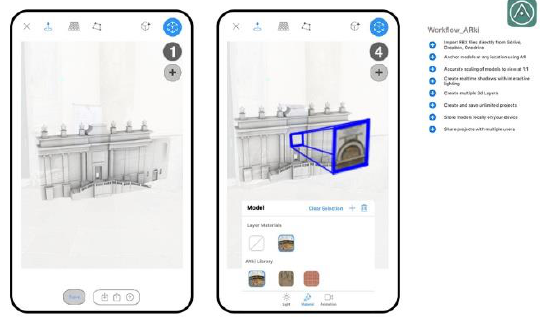
Figure 12. Visualization in AR with ARki